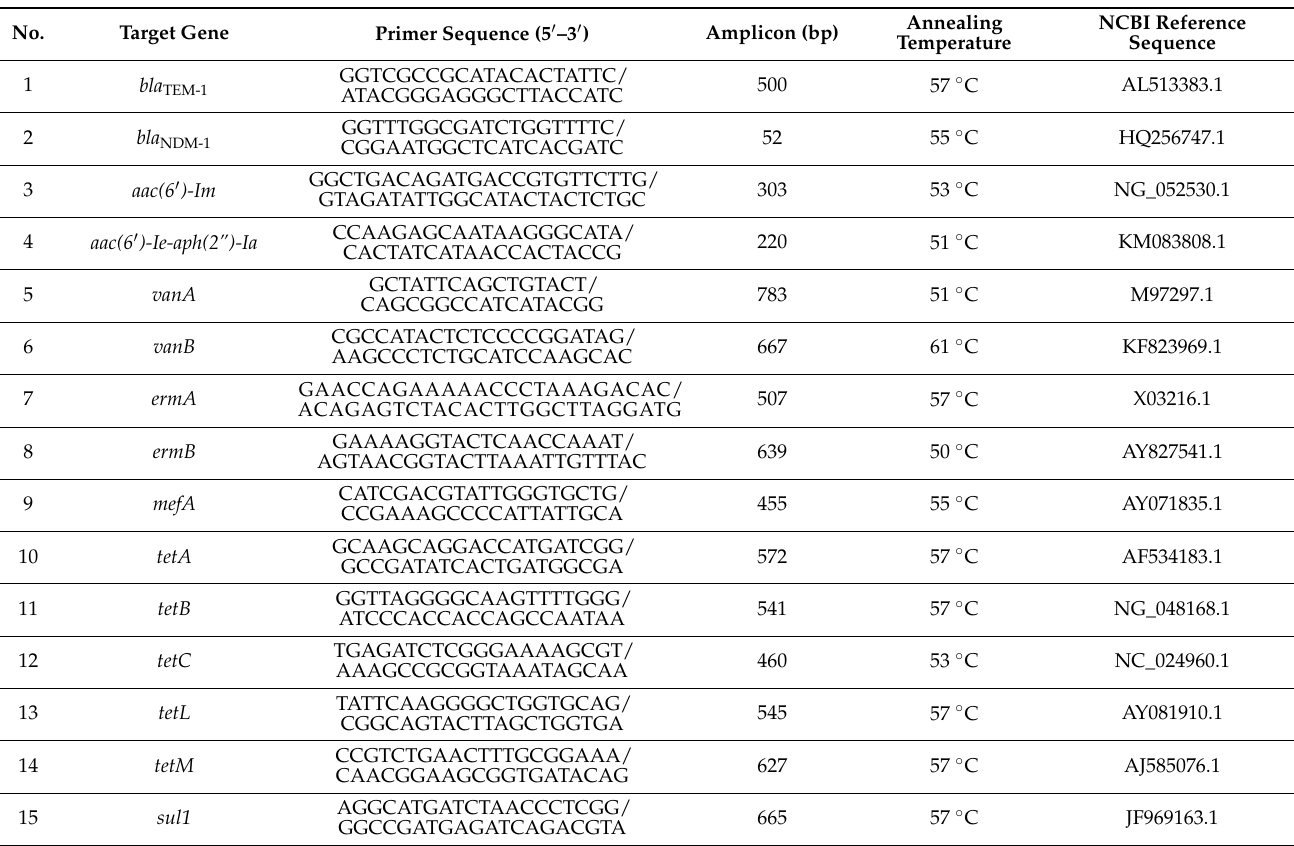
Table 2. Primers used for PCR